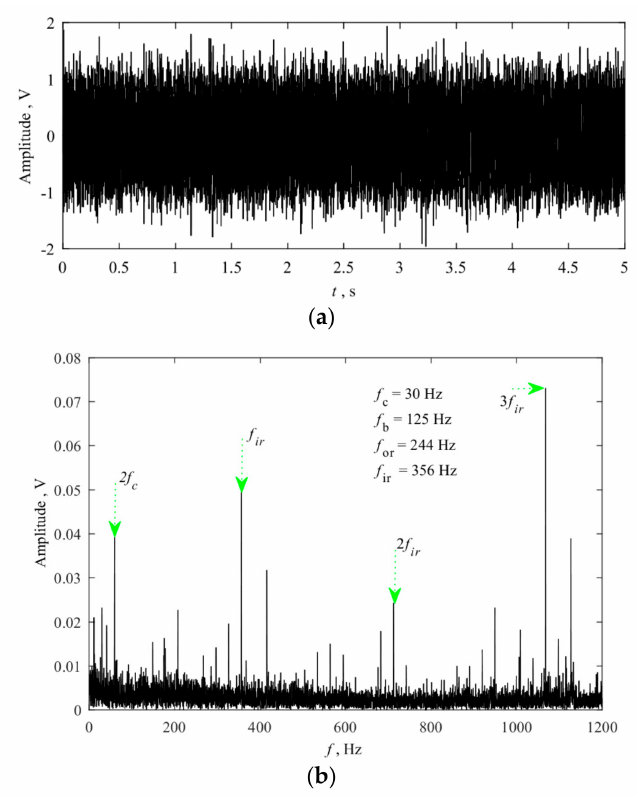
Figure 20. The vibration signal of MWA #5: ( a ) time domain waveform; ( b ) envelope spectrum.